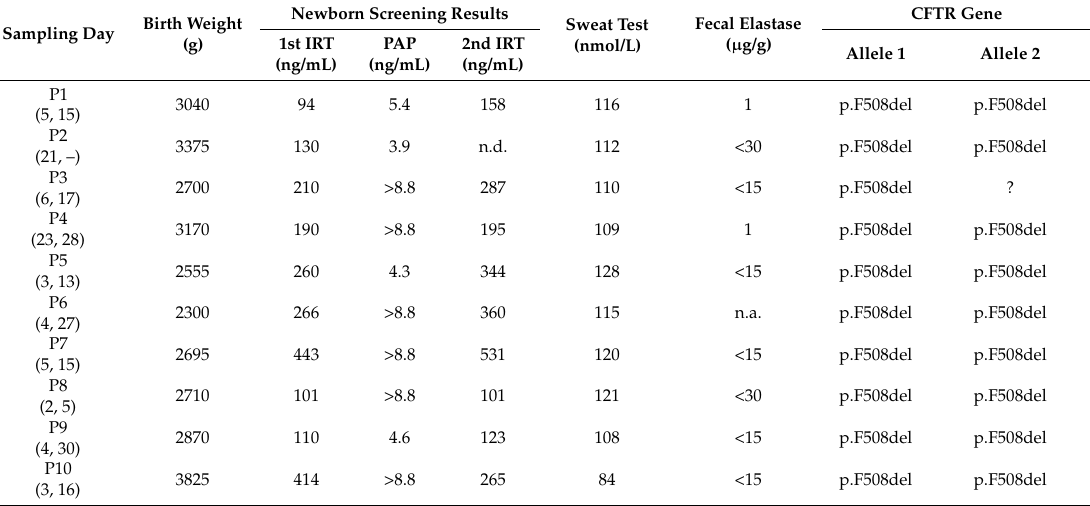
Table 1. CF patients identified in the CF-NBS pilot